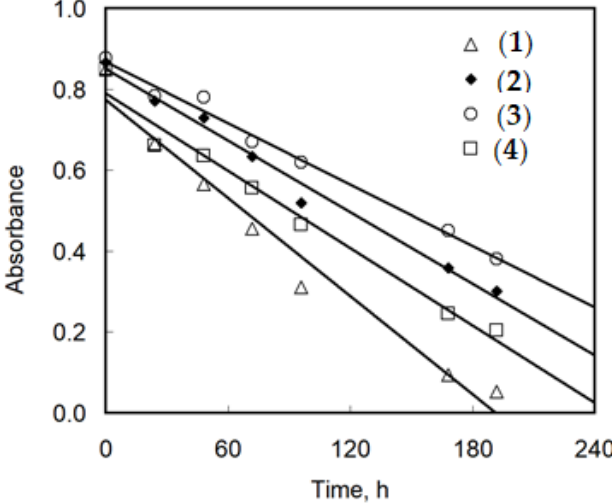
Figure 6. Changes in absorbance of methylene blue (MB) solution with time after addition of PMMA foil with a selected complex. MB = 1 × 10 − 5 M, PMMA foil surface = 0.64 cm 2 , T = r.t., l = 1 cm. Presented values are after blind test correction (R 2 = 0.9701 ( 1 ), 0.9876 ( 2 ), 0.9896 ( 3 ), 0.9769 ( 4 )).